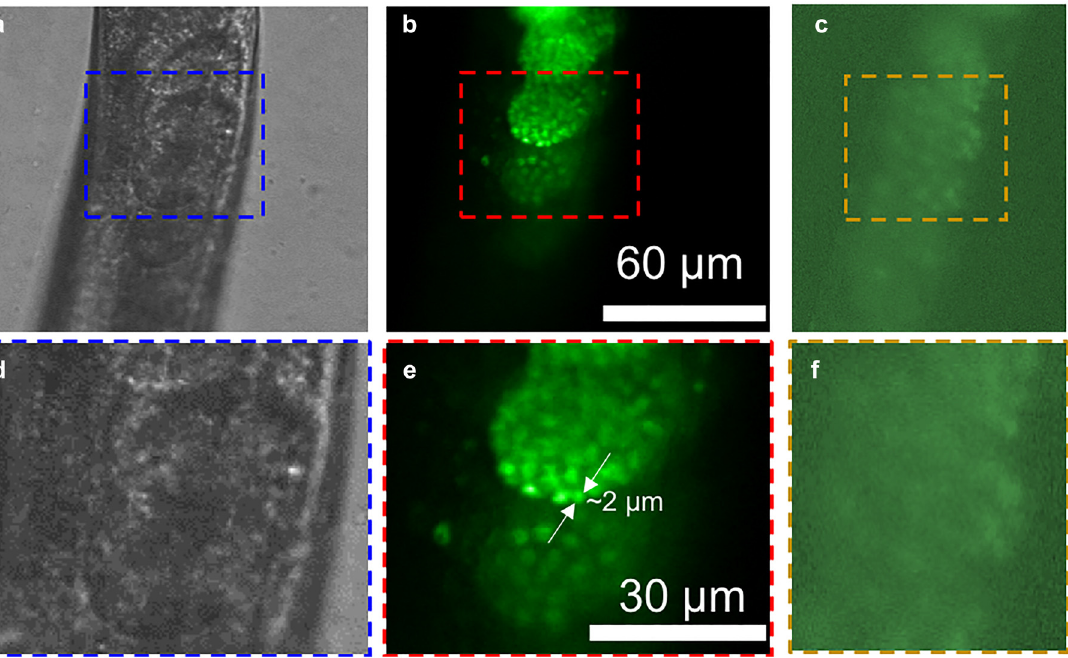
Figure 4: In vivo observation of green fl uorescence from GFP in a C. elegans. To image the green fl uorescence emitted from the fl uorescently tagged C. elegans , a 491-nm laser is utilized as the excitation of our LSFM. The peak wavelength of the fl uorescence is at 517 nm. (a) Bright- fi eld image of the C. elegans immobilized in agar. (b) LSFM image of the C. elegans . (c) Wide- fi eld fl uorescence image of the C. elegans . (d) – (f) Zoom-in to the dashed-box regions shown in (a) – (c), respectively. (d) – (f) are shown in the same scale.